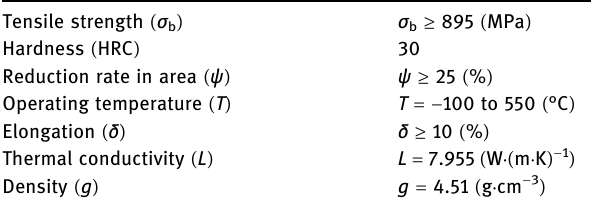
Table 1: Material properties of TC4 ( Ti – 6Al – 4V